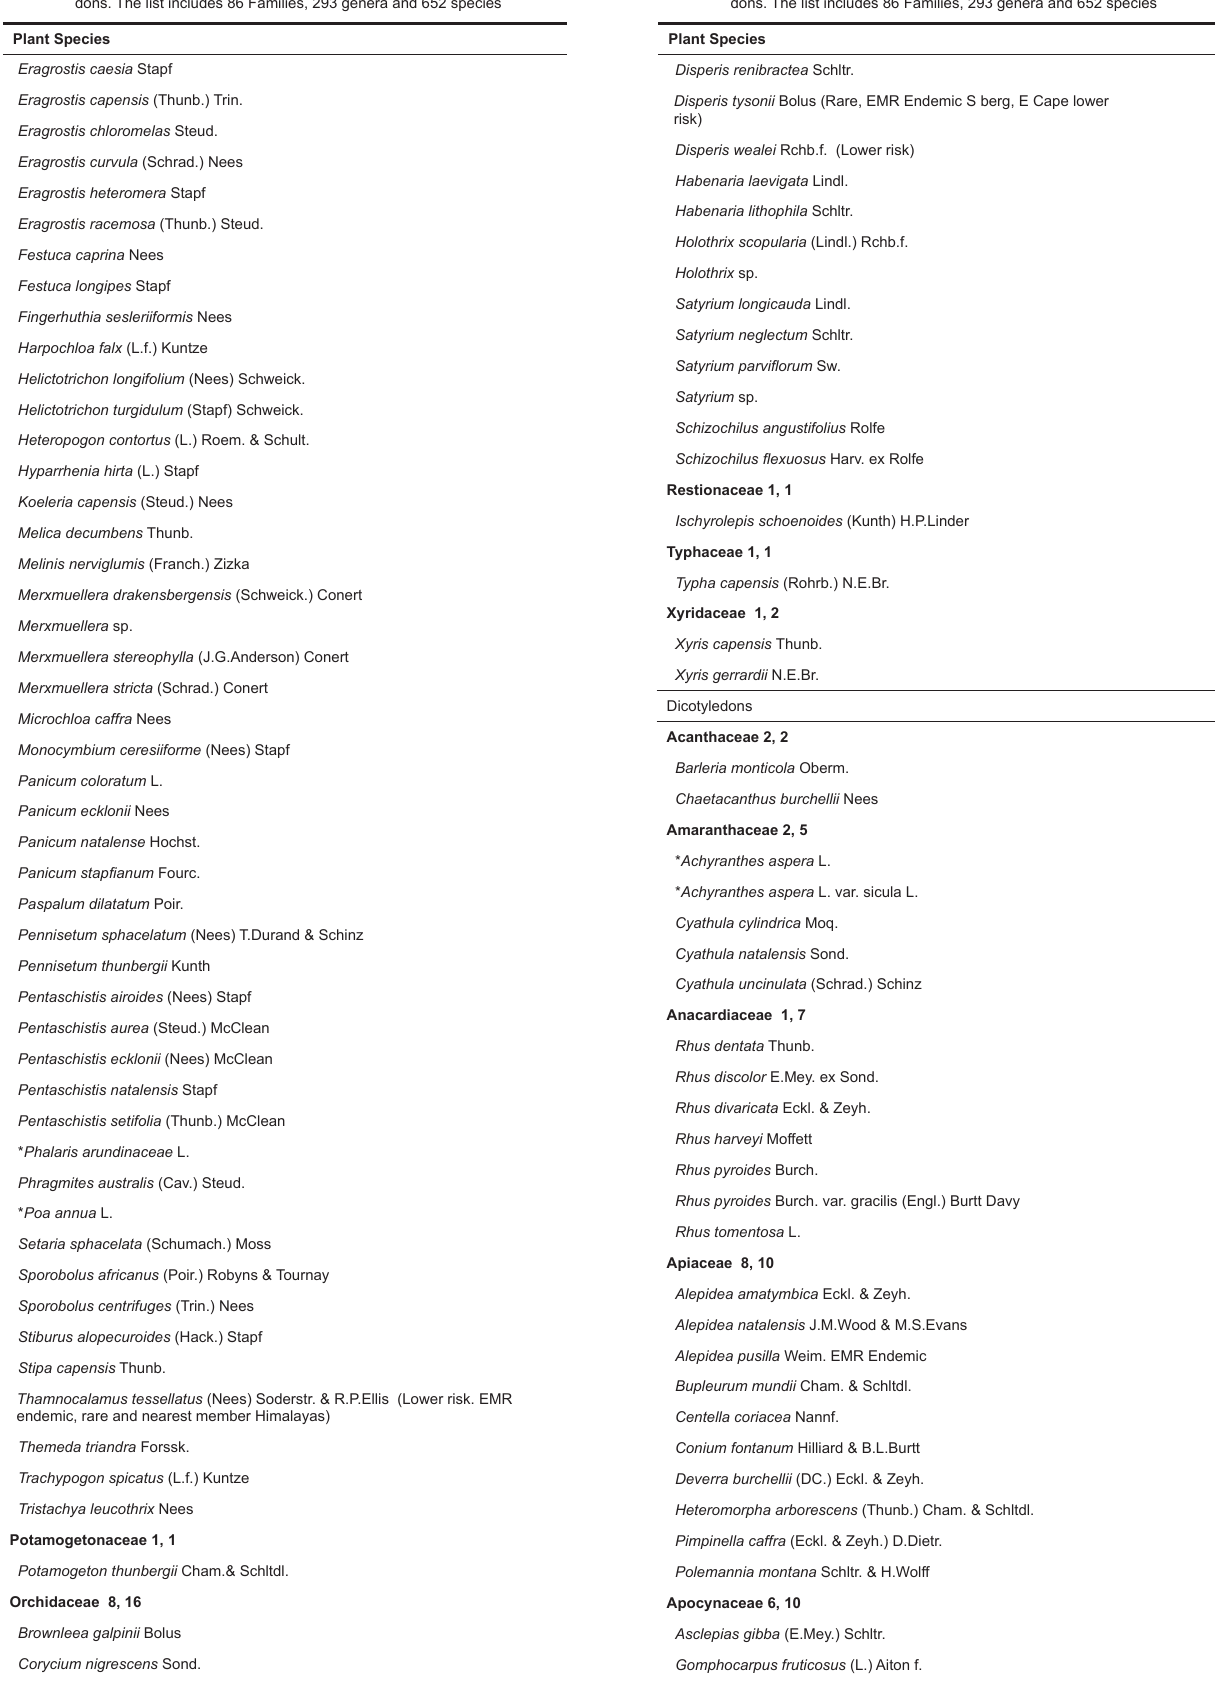
Tristachya leucothrix Nees Potamogetonaceae 1, 1 Potamogeton thunbergii Cham.& Schltdl. Orchidaceae 8, 16 Brownleea galpinii Bolus Corycium nigrescens Sond. Disa fragrans Schltr.